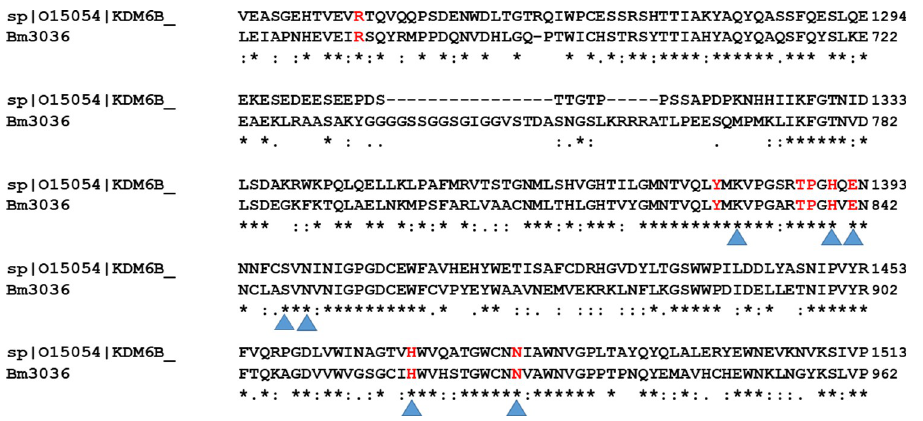
Fig 3. Residues in red represent contact sites for GSKJ1. Triangles represent contact sites for N-Oxalylglycine